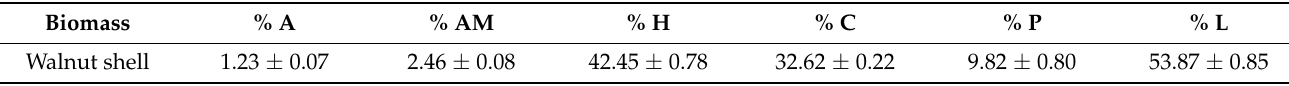
Table 3. Chemical composition of walnut